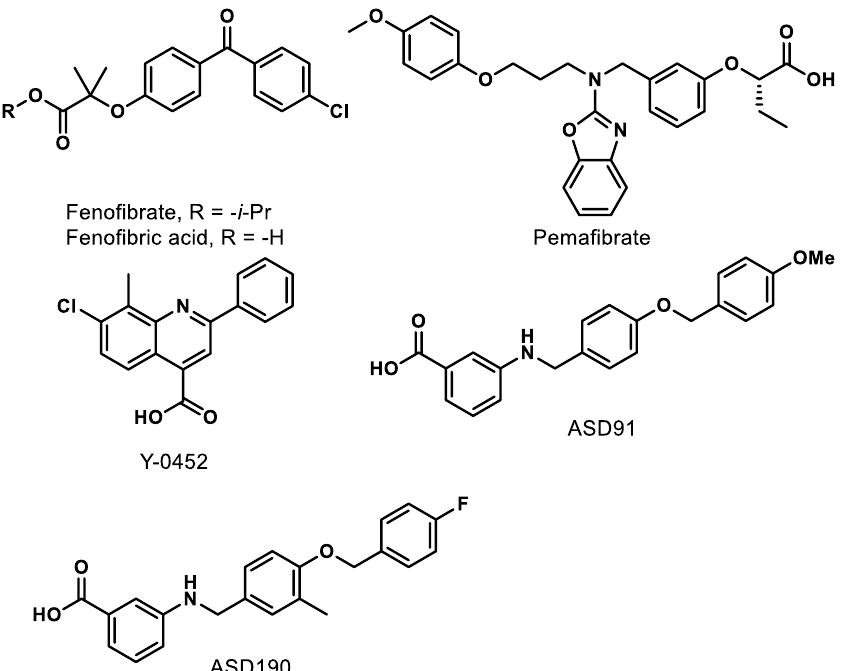
Figure 5. Representative synthetic PPARα agonists.